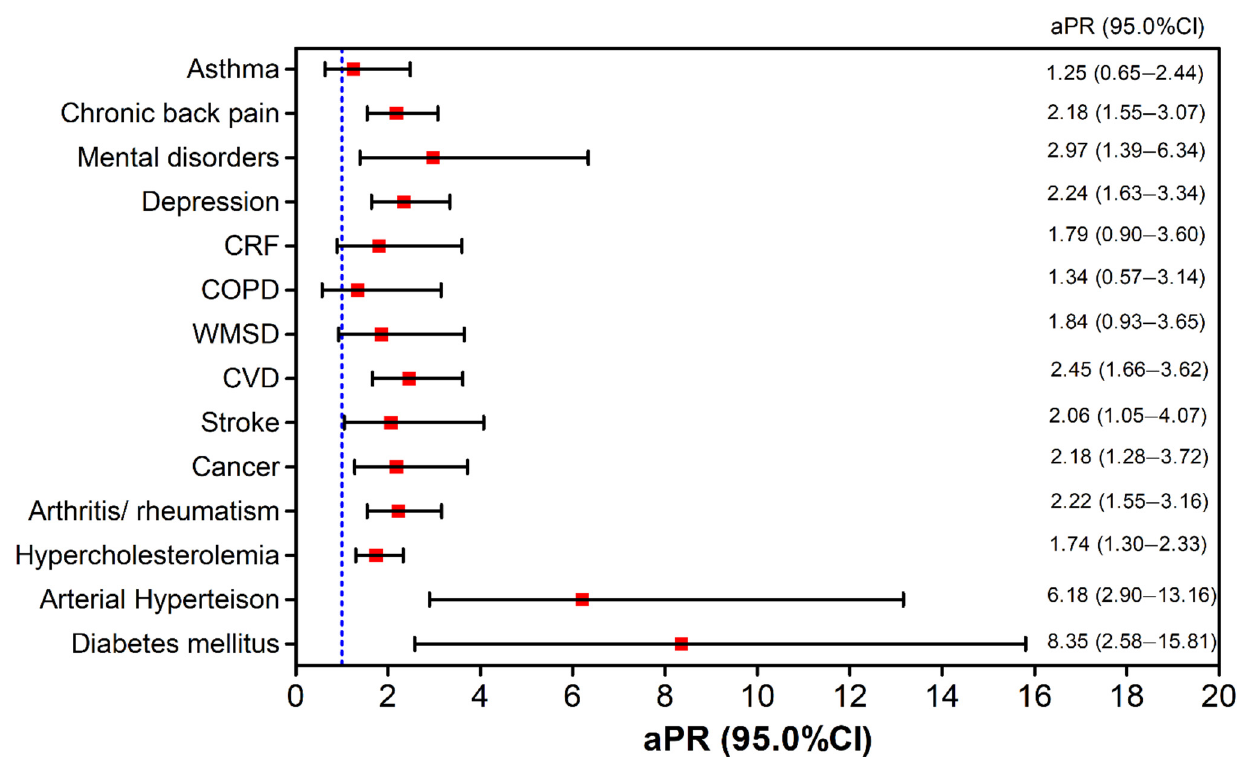
Figure 1. Analysis of the association between negative health self-assessment and chronic conditions in women in the Midwest region, Brazil, National Health Survey, 2013. aPR = Adjusted Prevalence Ratio; 95% CI = 95% Confidence Interval; WMSD = Work-related Musculoskeletal Disease; CRF = chronic renal failure; COPD = Chronic Obstructive Pulmonary Disease; CVD = cardiovascular dis- eases.